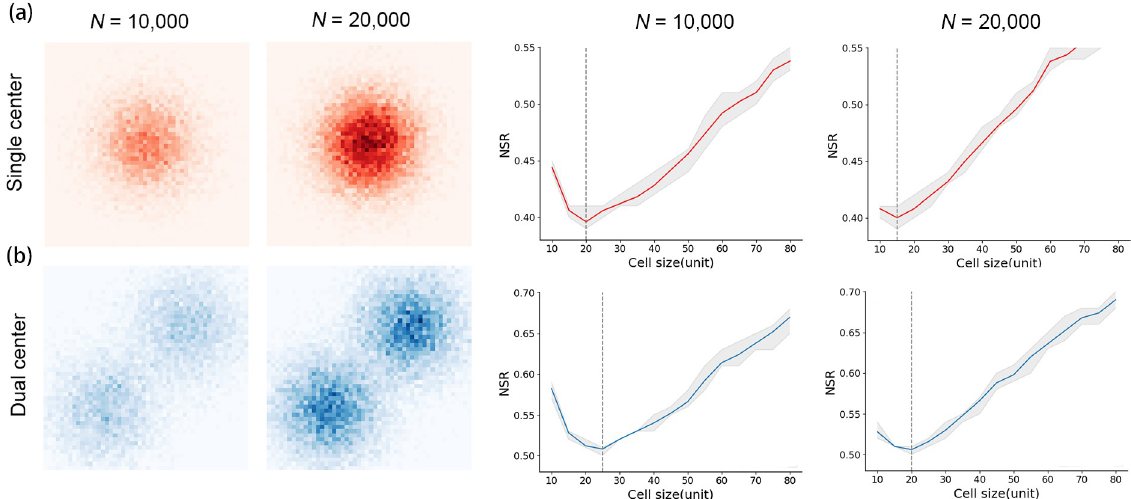
Fig 9. Spatial distribution of simulated data and the corresponding results of the scale effect. (a) single-centered data; (b) dual-centered data. N represents the number of points for each center.